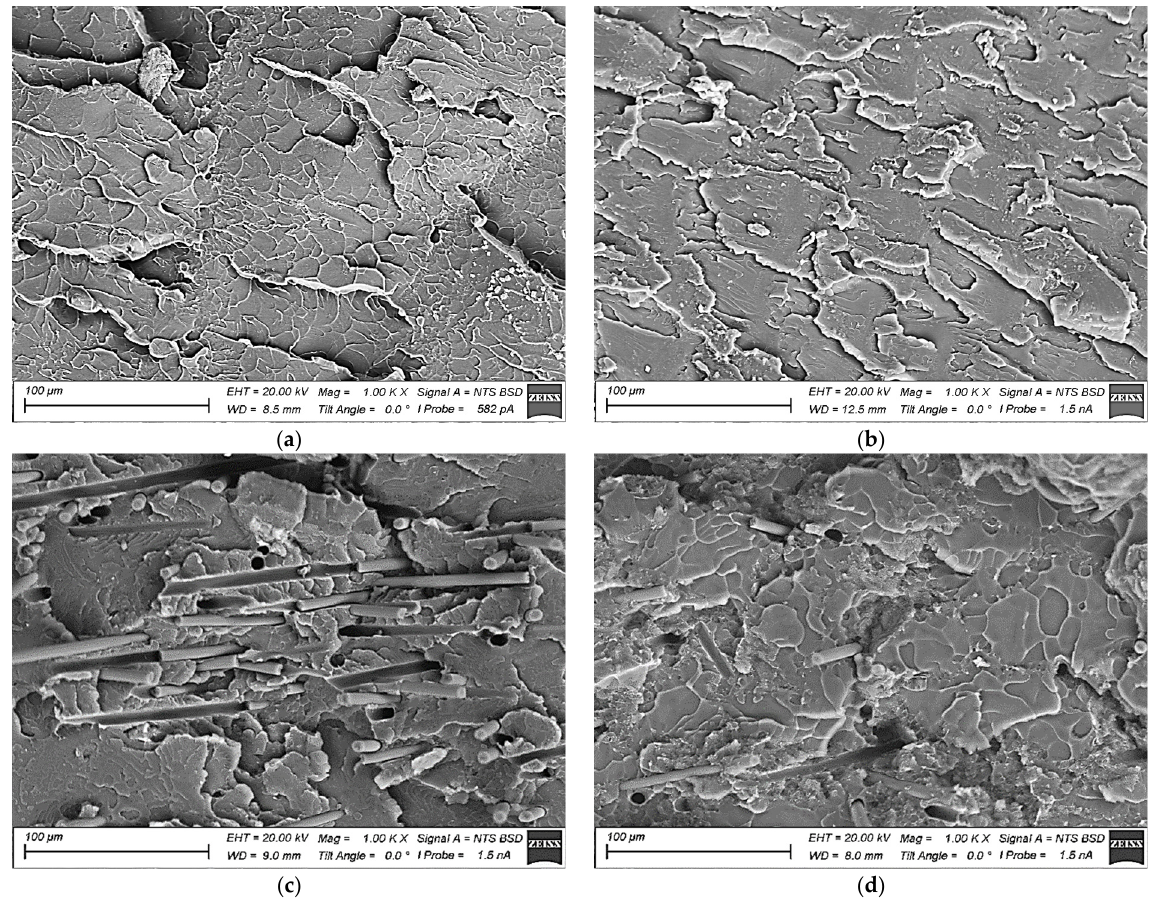
Figure 2. SEM micrographs of the structures of the neat PI ( a ), neat PEI ( b ), PEI/10CCF/1HNT ( c ) and PEI/10CCF/1CNT ( d ) nanocomposites.